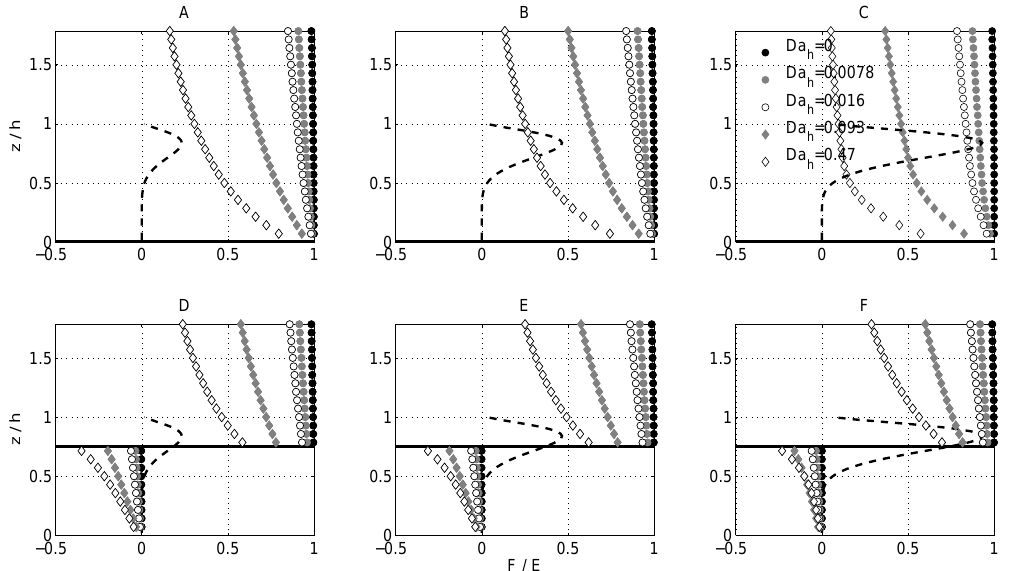
Fig. 3. Effect of canopy density on flux-to-surface-exchange ( F / E ) ratio. The source height, represented by the solid black line, is at the ground level in Panels (A) – (C) and at the displacement height in Panels (D) – (F) . In Panels (B) and (E) the canopy density corresponds to that in SMEAR II and used also in Fig. 2. In Panels (A) and (D) the canopy density in half of that in Panels (B) and (E) , and in Panels (C) and (F) the canopy density is double of that in Panels (B) and (E) . The canopy-top Damk¨ohler refers to the above canopy chemical lifetime in all Panels. The dashed black line represents the foliage